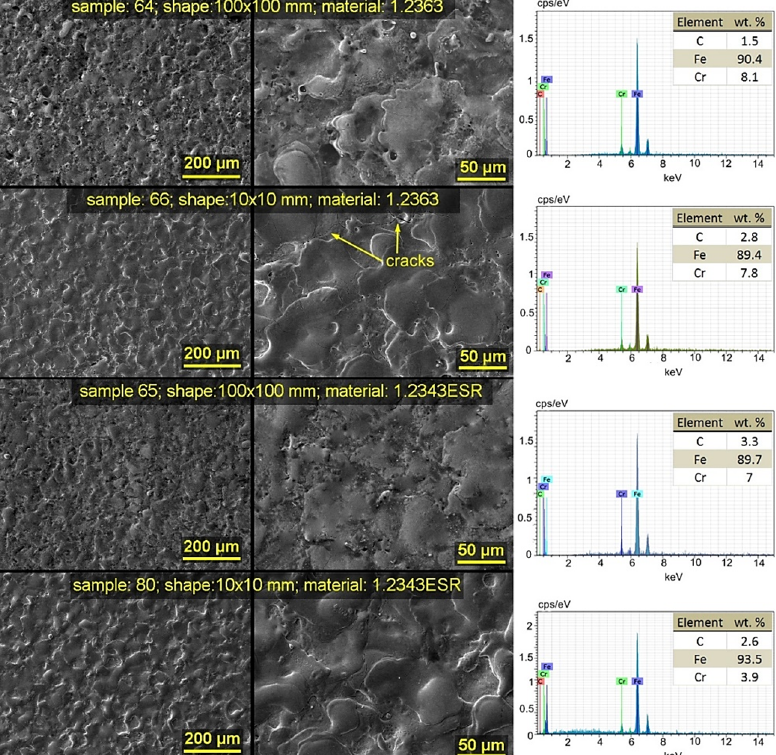
Figure 4. Morphology of the scanning electron microscopy (SEM) samples (SE) including chemical composition analysis. Table 3. Analysis of defect occurrence on the surface of individual samples.